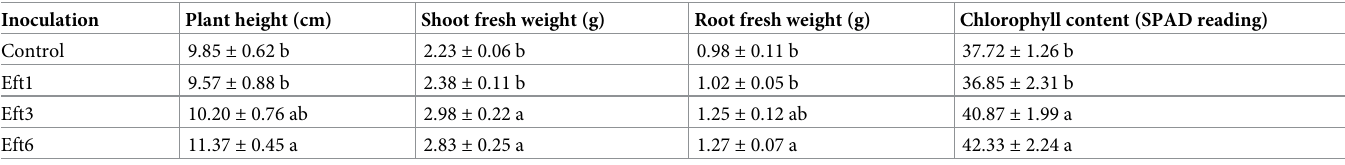
Different letters indicate the significant differences among various treatments at P <